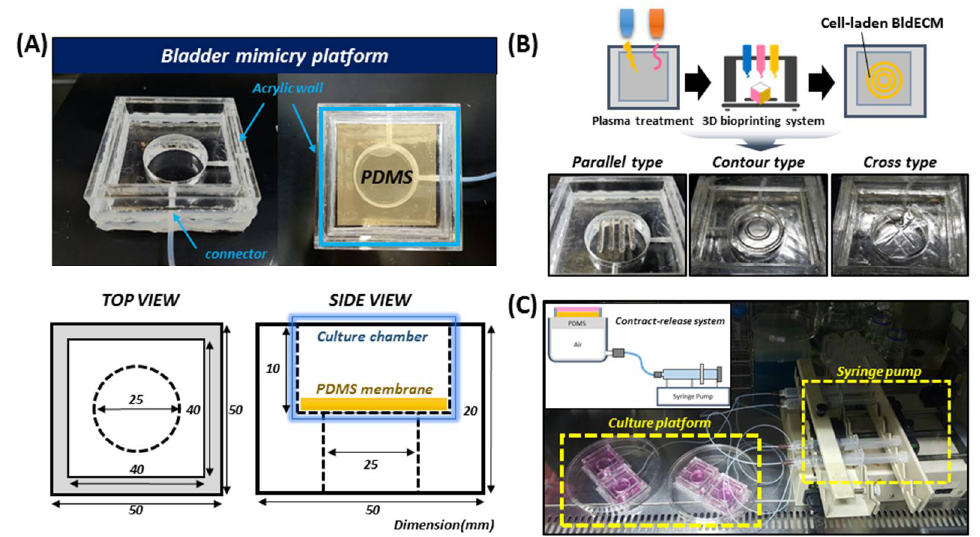
Figure 3. Development of a bladder mimicry platform that incorporates a contract-release system (CRS). ( A ) Design of the bladder mimicry platform comprising a vacuum chamber, medium container, and PDMS substrate; a snapshot of the bladder mimicry platform (above) and a detailed scheme of platform design (below, all dimensions are mm.) ( B ) 3D bioprinting of the bladder tissue models with various structures. Constructs of the parallel type (left), contour type (middle), and cross type (right). ( C ) Image of integrating a pressure-driven CRS into the model; cell-printed bladder tissues in the culture platform were stimulated mechanically by CRS for 10 days.